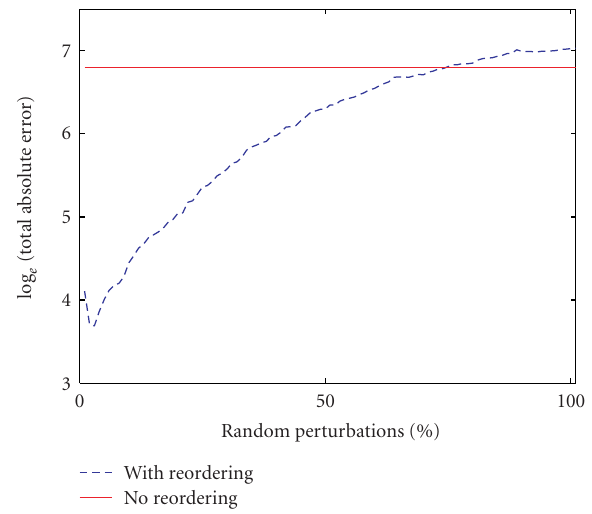
Figure 6: Comparison of errors in the reconstruction for the actual MR heart image in Figure 5(d) without reordering and with reordering as a function of perturbations in the exact spatial ordering.